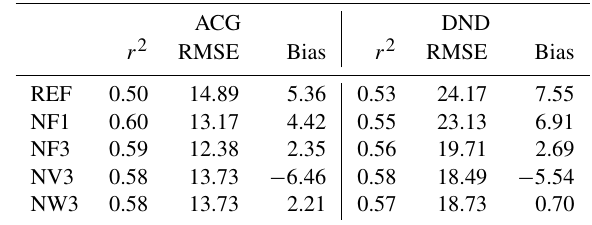
Table 3. Model performance at ACG (Alaska Coast Guard, USA) and Dahlen (DND) in terms of r 2 , RMSE and bias (ppb) of a selec- tion of simulations according to Table